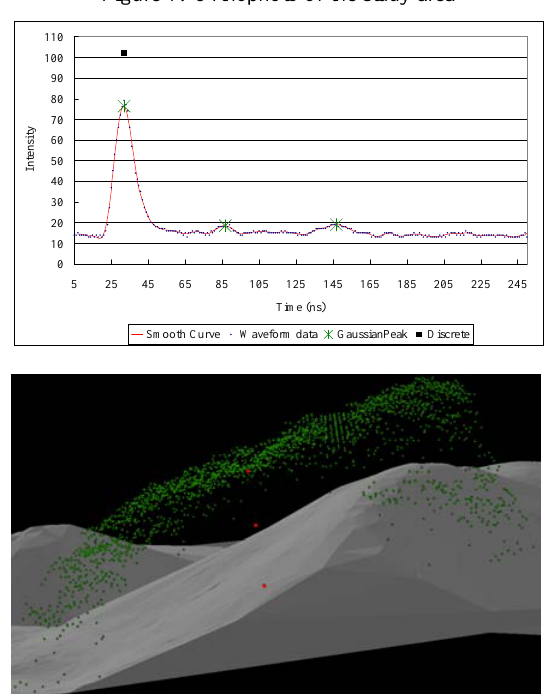
Figure 2. Top: Discrete return pulse (black square dot), raw full waveform data (blue dots), smoothened waveform (red curve) and Gaussian peaks (crosshair symbols). Bottom: Discrete return pulses (green dots), full waveform return pulses (red dots) constructed from the Gaussian peaks depicted in the top